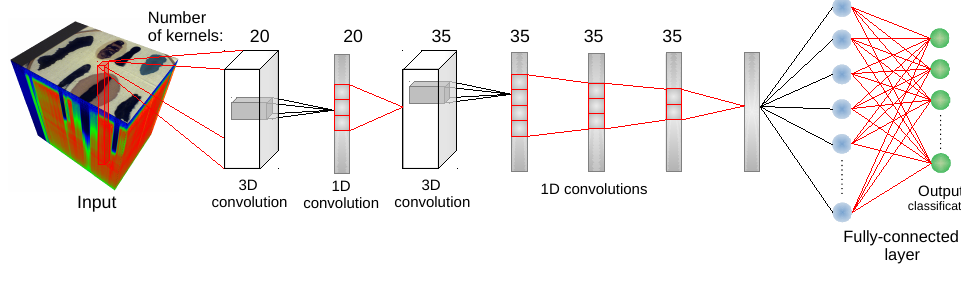
Figure 7. Schematic of the 3D CNN architecture [49] used in